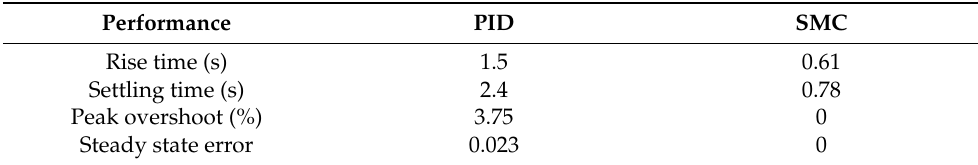
Figure 12. Controlled response: ( a ) step response, ( b ) multi step response, ( c ) disturbance rejection. Table 3. Performance of the